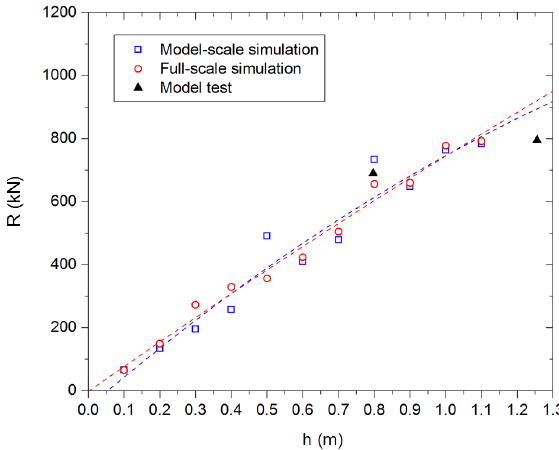
Figure 27: The ice resistance R that the vessel encoun- tered, running astern in the ice of increasing thickness h (the scaled model-scale simula- tion results and the full-scale simulation re- sults with scaled ice and ship